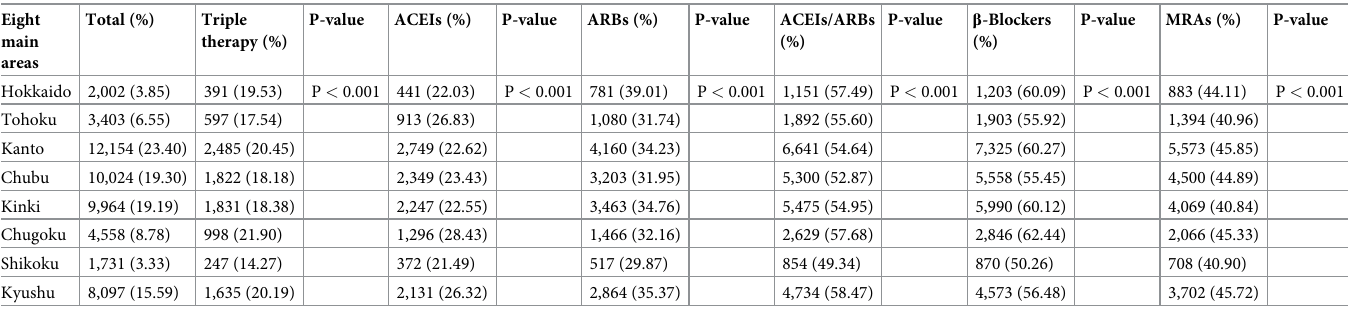
Table 2. Drug therapy rate of patients with HF in eight major regions in